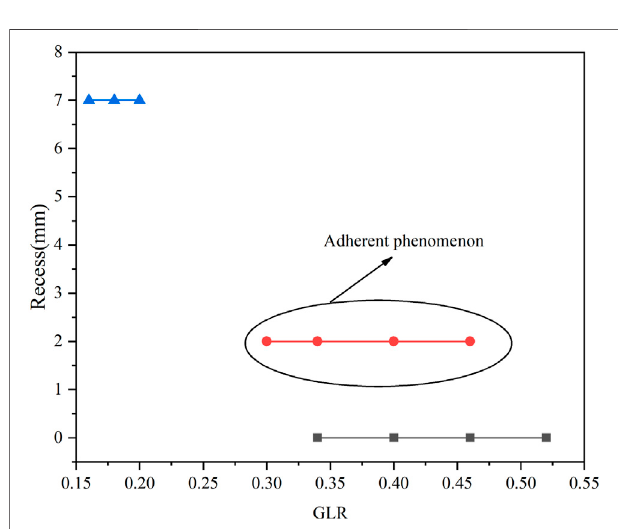
FIGURE 15 | Self-pulsation operating condition range (ml (cid:2) 20 g/s).